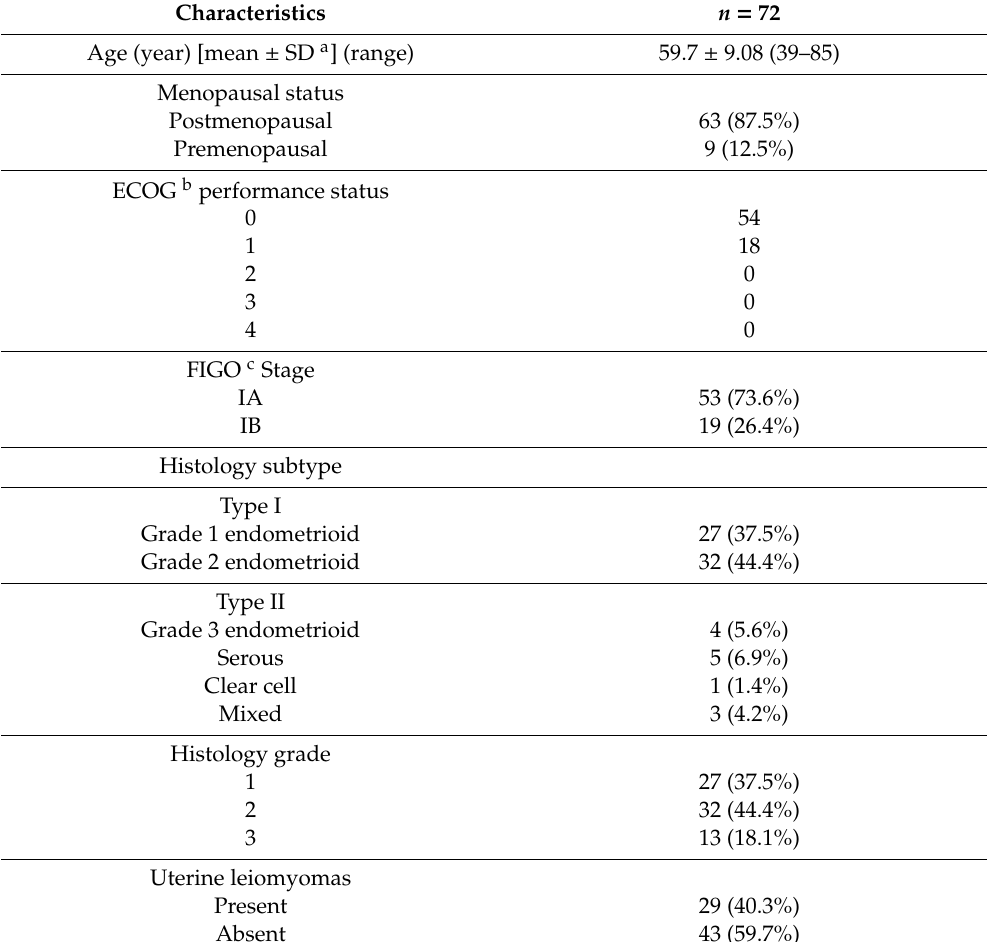
Table 1. Clinical and pathologic characteristics of all